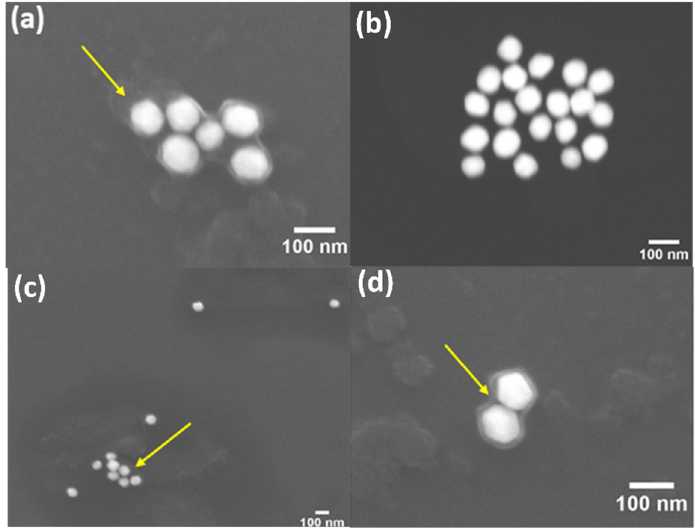
Figure 3. SEM images of AuNPs stabilized by ( a , b ) cationic dendronized AuNP-(dendron-NH 2 ), and ( c , d ) anionic dendronized AuNP-(dendron-CO 2 H). The arrows highlight the contrast between the organic stabilizing and the metallic portion.